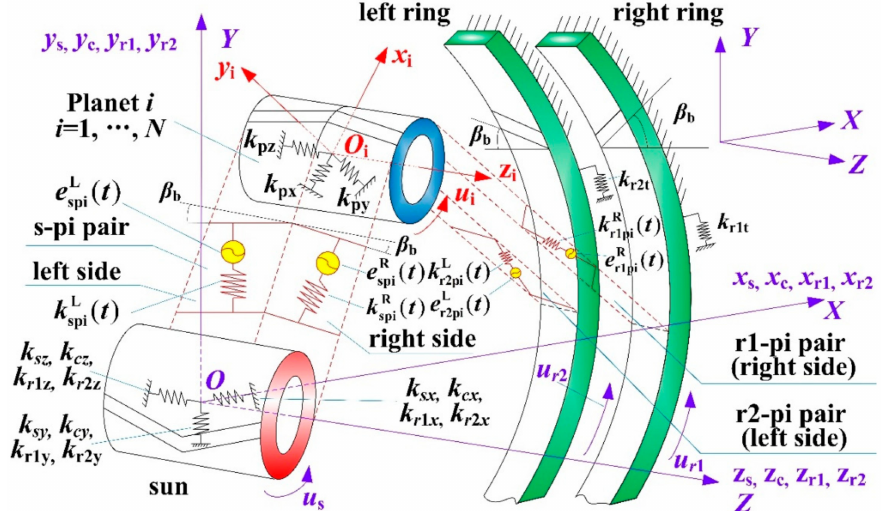
Figure 2. Bending-torsional-axial coupling dynamic model of herringbone planetary gears taking both sides of each gear into consideration. For simplicity, only one planet–gear is exhibited and the carrier is not displayed in the